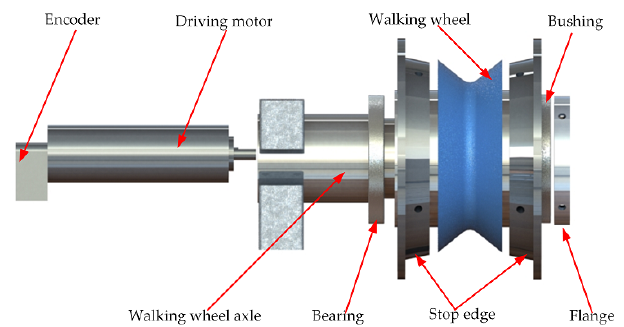
Figure 3. The walking component of the FPLIR.